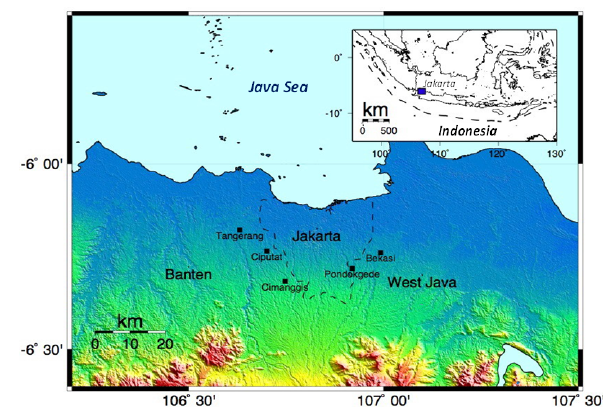
Figure 1. Location of Jakarta, the capital city of Indonesia.